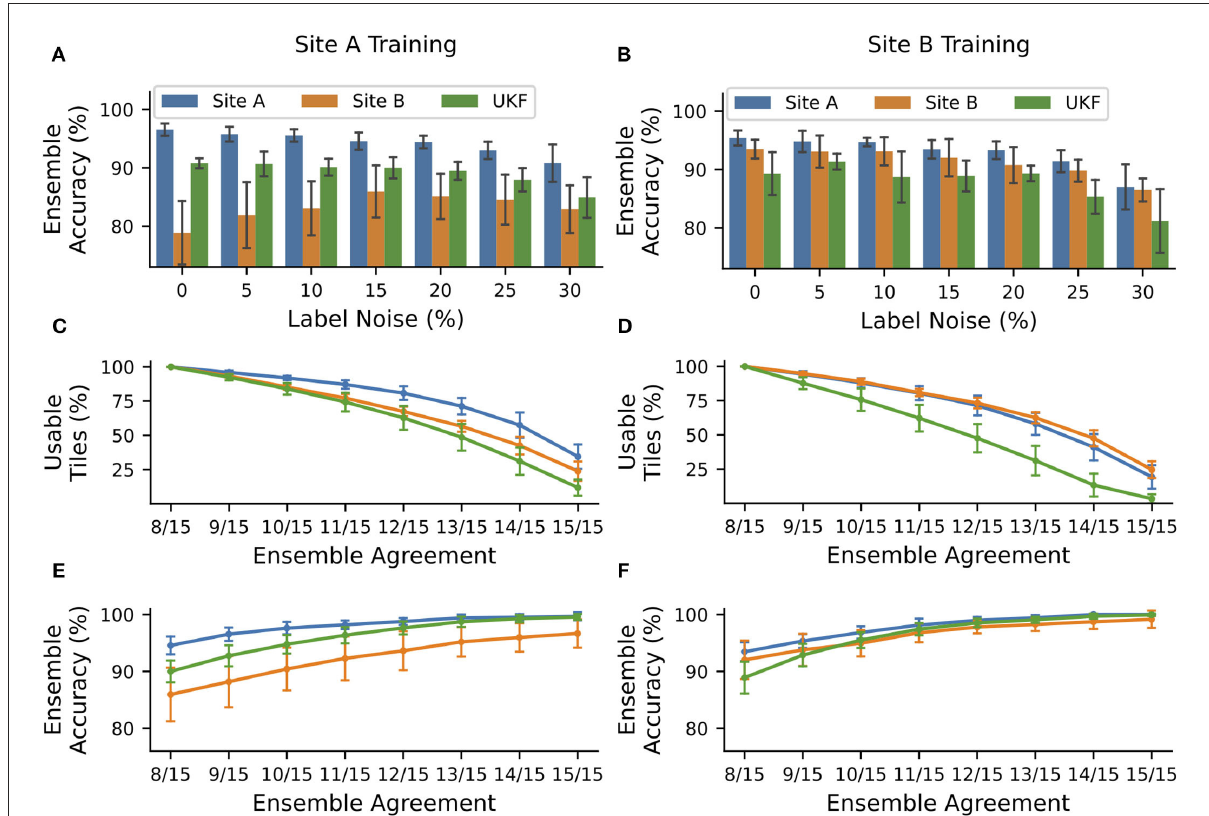
FIGURE4 NoisyEnsembles could identify tiles with uncertain predictions. CNNs were trained with data from tissue source site A (left column) or tissue source site B (right column), while a defined amount of tiles was deliberately mislabeled in the training dataset. For each patient, either healthy or cancerous tiles were used during training. Hold-out test sets were chosen randomly and with the remaining data 15 CNNs with different train-validation splits were trained and combined with a bagging ensemble. The complete procedure was repeated 10 times. (A,B) Average ensemble accuracy for different test datasets. (C–F) NoisyEnsemble with a noise level of 15% during training. (C,D) Number of tiles with a valid ensemble prediction for the respective ensemble agreement. (E,F) Ensemble accuracy for individual levels of ensemble agreement. Predictions with smaller rates of the agreement were ignored in the respective categories. Error bars depict standard